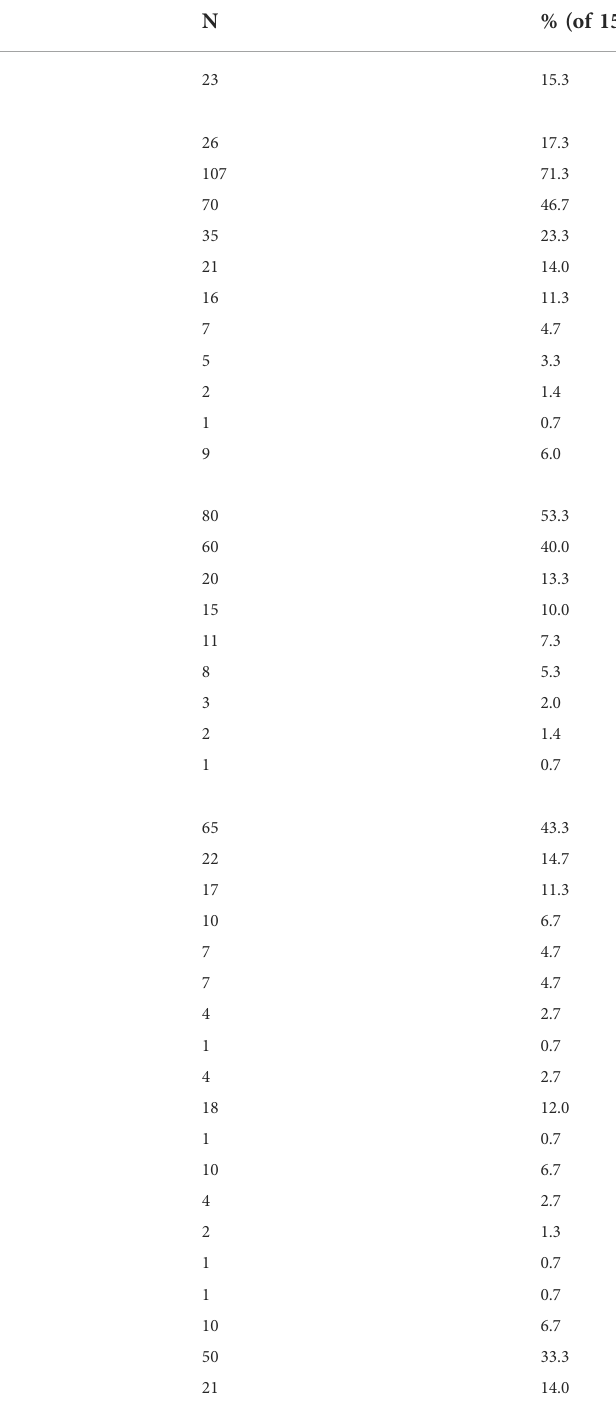
TABLE 4 The TDM available anti-infective